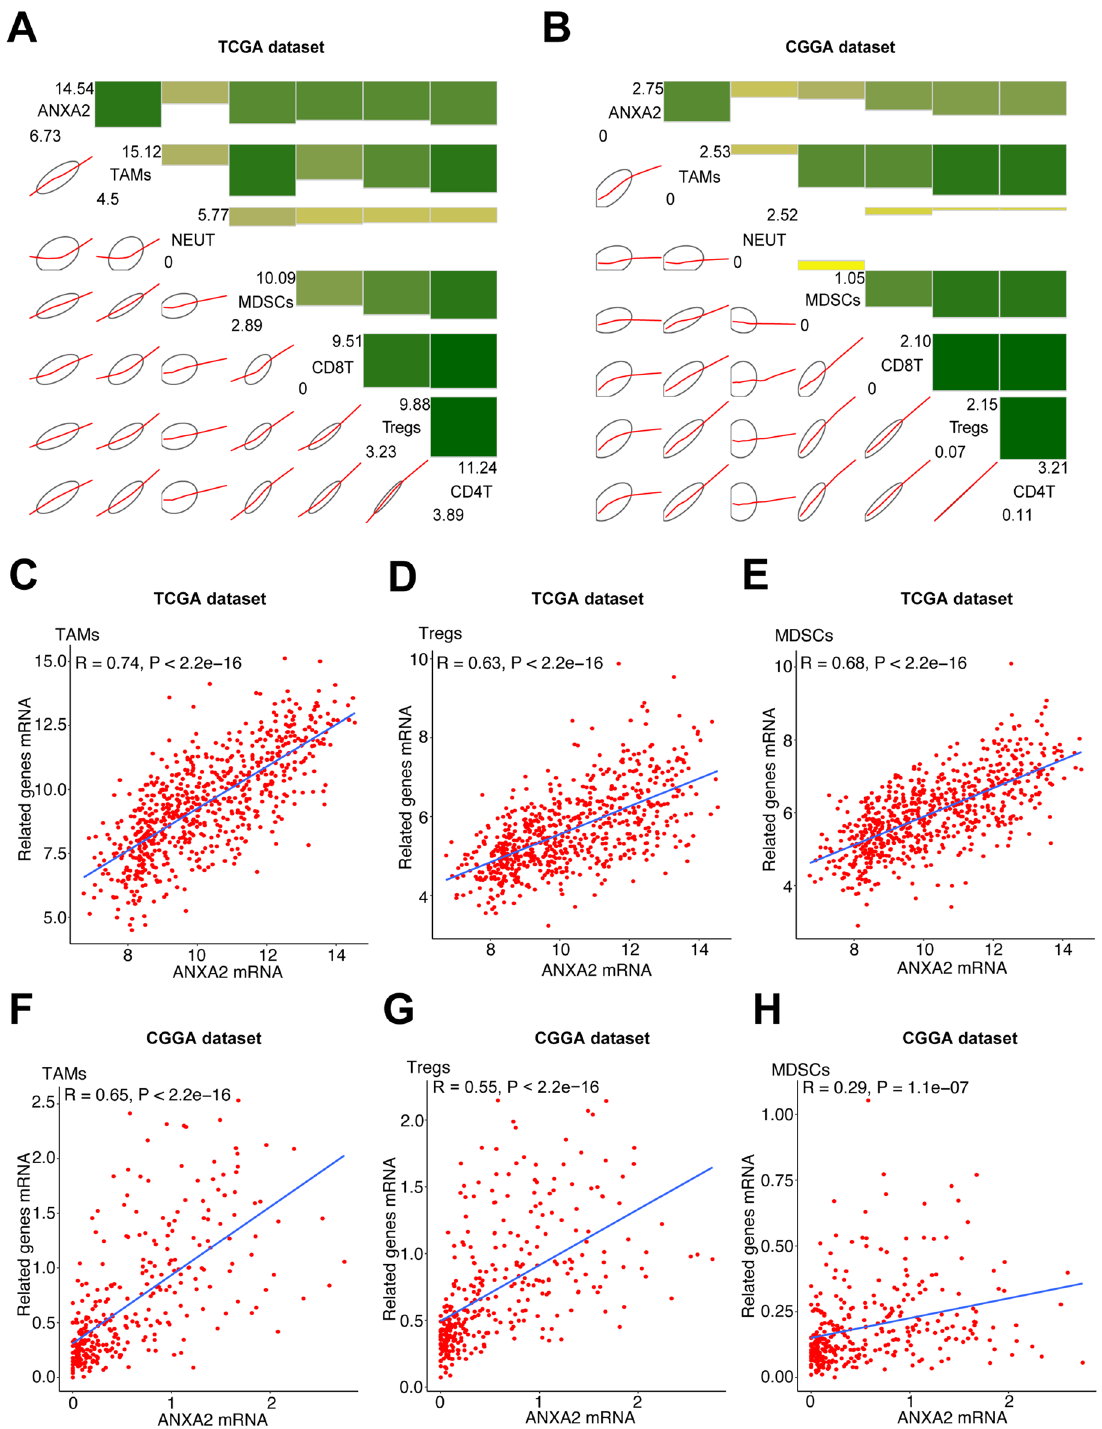
Figure 8. ANXA2-related infiltrating immune cells in glioma. ( A,B ) Correlograms showing the correlation between ANXA2 and immune cell infiltration level based on both datasets. Green represents positive correlations, and yellow represents negative correlations. Color intensity and the size of the bars and ellipses are proportional to the correlation coefficients. The leading diagonal contains the minimum and maximum values of variables. ( C–H ) ANXA2 was significantly positively correlated with TAMS, Tregs and MDSCs in both datasets. Each point represents a glioma sample. A regression line was fitted to the dot